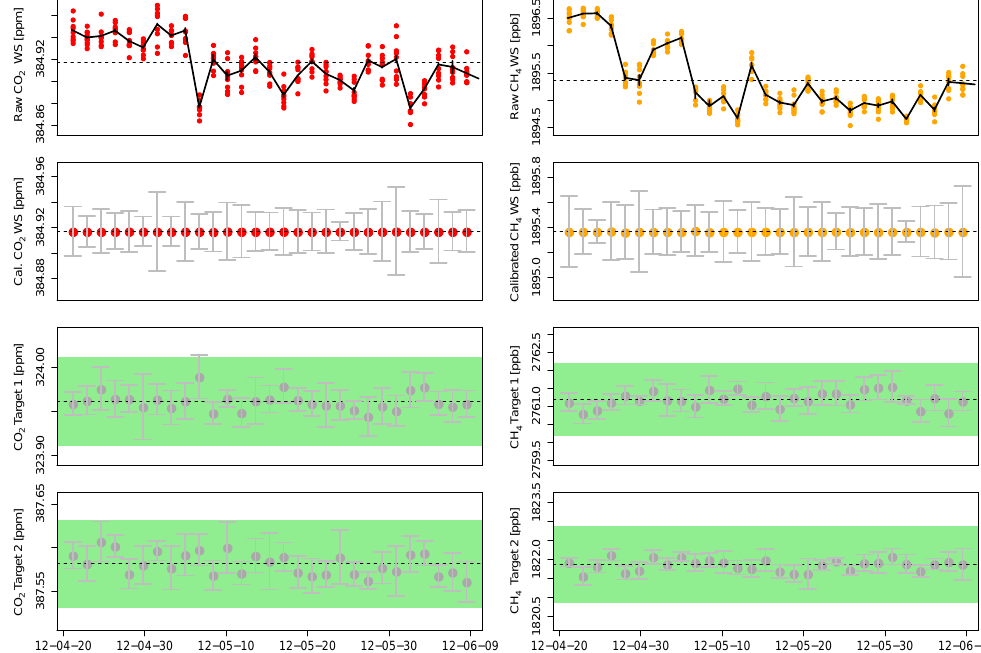
Figure 3. Left-hand side panels: CO 2 working and target cylinder measurements of the travelling instrument at PAL. Top panel: raw 1min readings of the WS (red points) with LOESS fit (solid black line) and the mean reading (dotted grey line). Second panel from the top: average WS readings after calibration. Lower two panels: target cylinder measurements. The green area represents the average reading ± half of the WMO compatibility goal. Right-hand side panels: Same results for CH 4 .